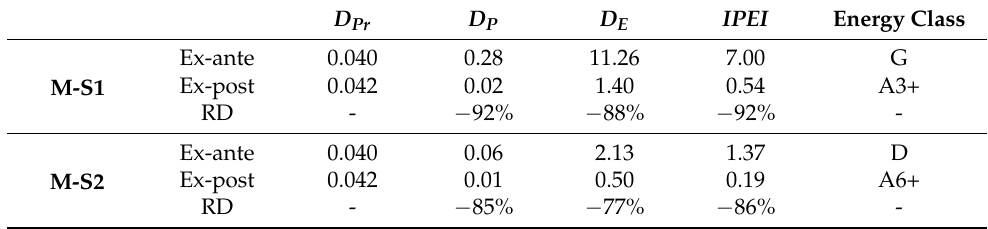
Table 12. Energy performance indicators for ex-ante and ex-post installations of driveway